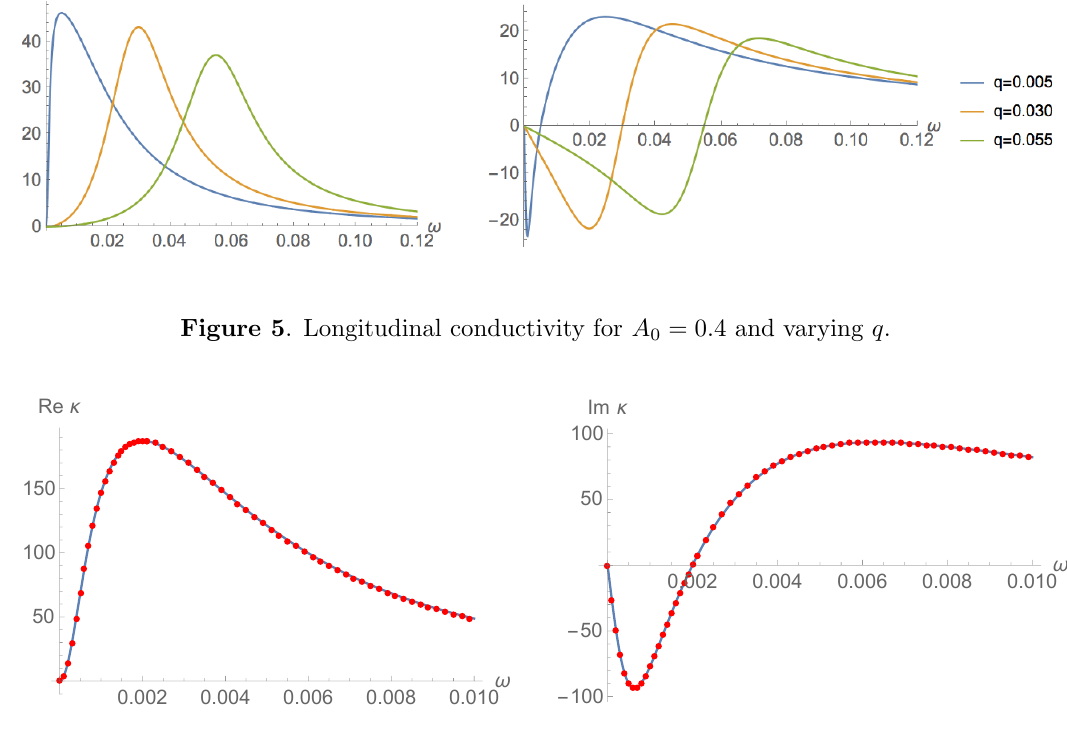
Figure 6 . Conductivity for A 0 = 0 : 2 and q = 2 (cid:1) 10 (cid:0) 3 . The points correspond to the numerical data, while the solid line is obtained from a